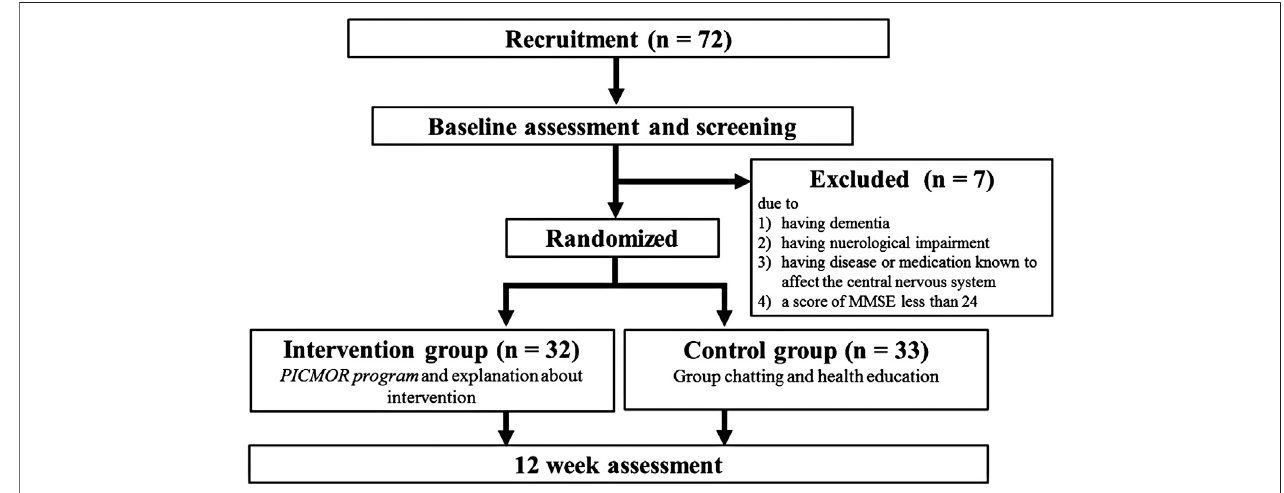
FIGURE 1 | CONSORT diagram